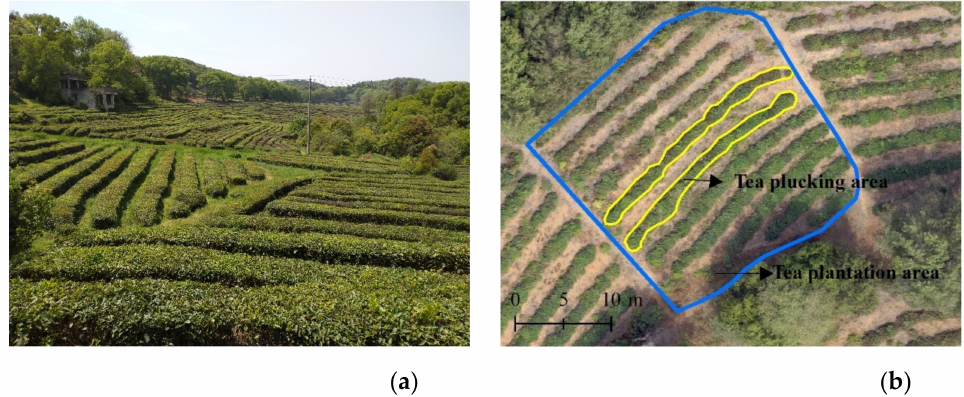
Figure 1. ( a ) A close-up photo of Huashan Tea Garden (the study area); ( b ) illustration of tea plantation area and plucking